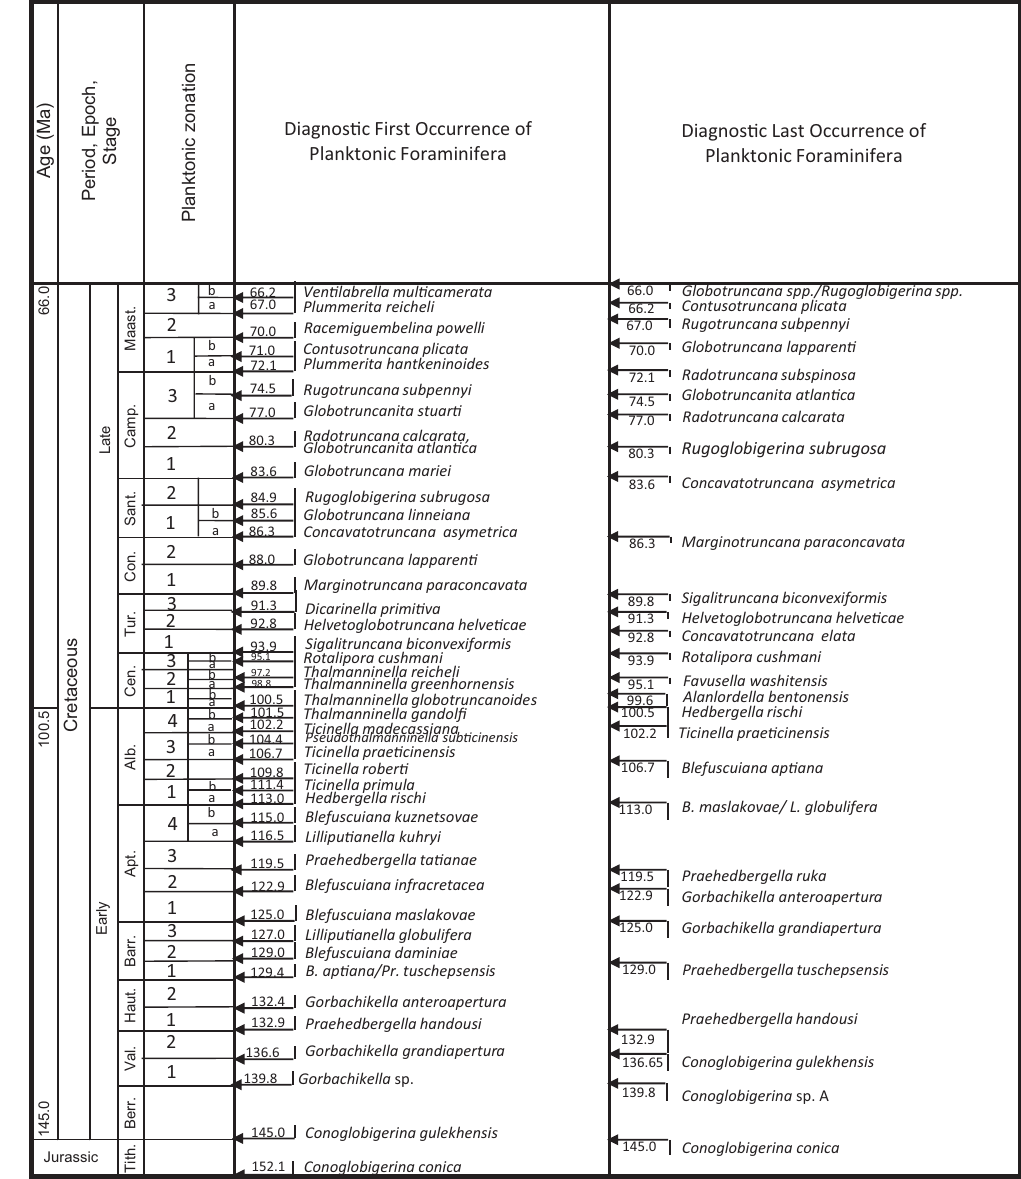
139.8 Gorbachikella sp.